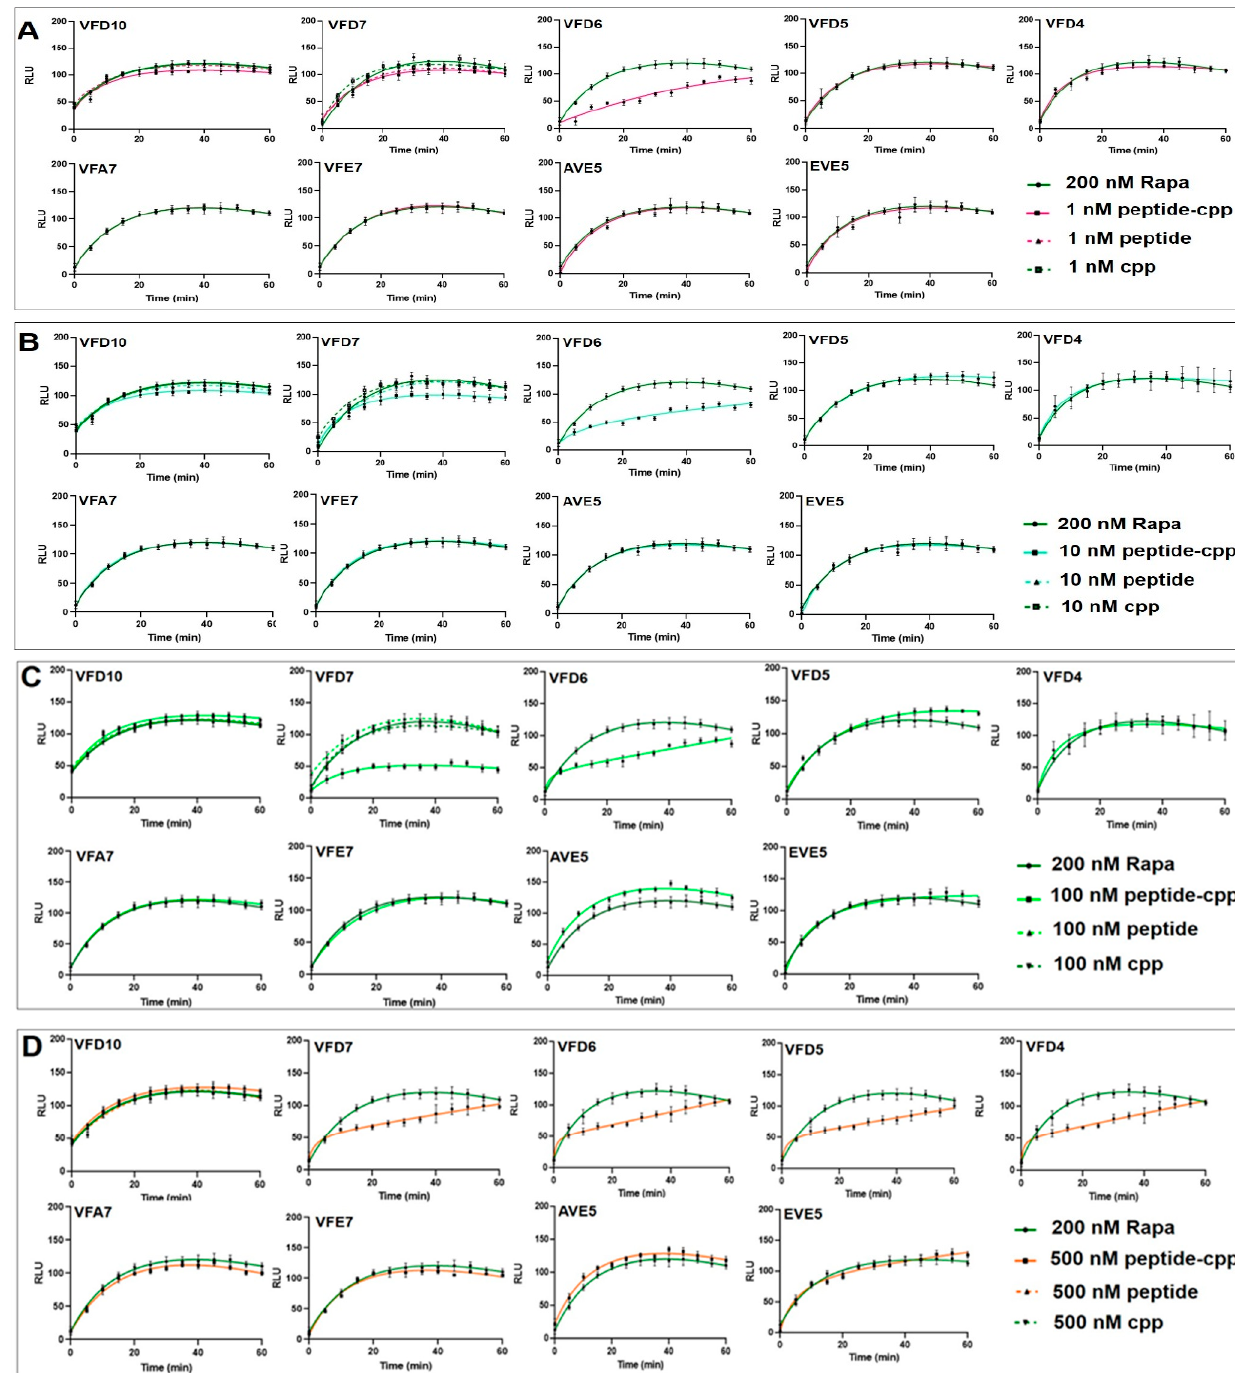
Figure 3. Effect of VFD7-cpp and derived peptides on rapamycin-induced interaction of FKBP–FRB. HEK293 cells co-transfected with NanoBiT ® luciferase structural complementation reporter system, as described under Experimental procedures. Note that VFD7-cpp and VFD6-cpp with greatest potencies, and VFD5-cpp and VFD4-cpp with lower potencies, prevented the rapamycin-induced interaction between FKBP–FRB within HEK293 cells. Results are representative of at least five independent determinations conducted in triplicates. Variation among replicates were <10% (error bars). ( A – D ); color lanes indicate the experimental condition of each experiment. Relative luminescence units, RLU.